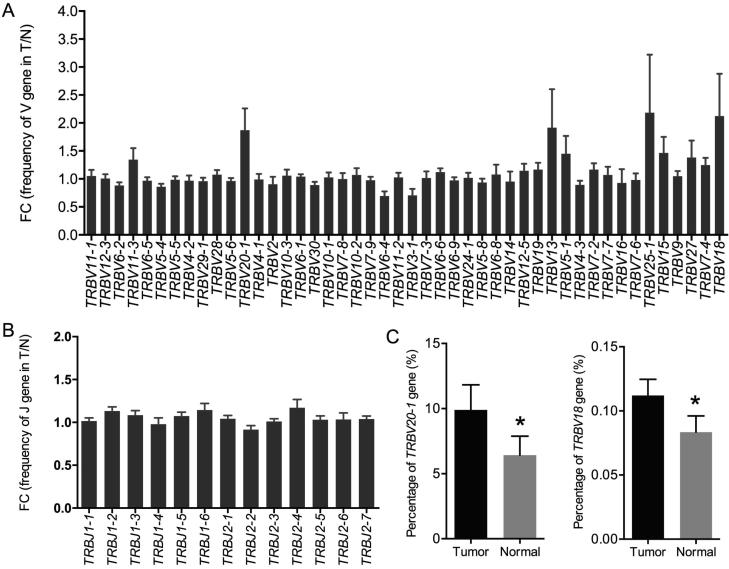
Usage frequency of V and J gene segments between tumor tissues and normal tissuesA. V gene usage frequency in tumor tissues and normal tissues. B. J gene usage frequency in tumor tissues and normal tissues. C. V genes with significantly higher usage in tumor tissues than in normal tissues. FC was calculated as the mean frequency in tumor tissues divided by that in normal tissues. Frequencies with FC >1.5 or <1/1.5 were considered significant. FC, fold change. *, P < 0.05, t-test.